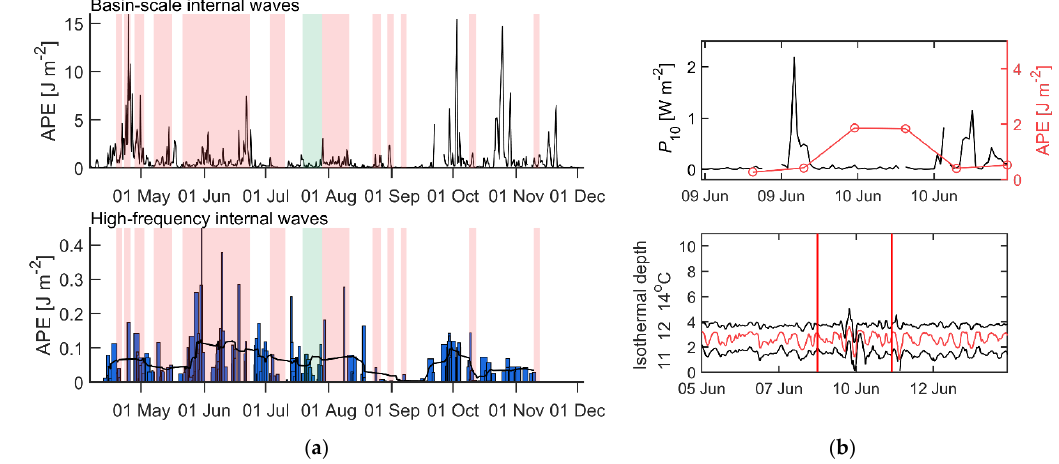
Figure 6. ( a ) Average available potential energy (APE) in basin-scale internal waves (upper panel) and in high-frequency internal waves (lower panel) throughout the measurement period in Bautzen Reservoir. The red-shaded areas correspond to the presence of the basin-scale waves with 8–9 h period, the green-shaded area shows the presence of a wave with 21 h period. The width of the bars is not to scale but is proportional to the event duration (i.e., narrow bars indicate shorter events where waves are present, and wider bars indicate longer events). The black line in the lower panel (a) shows a moving average of the APE. ( b ) Sample data demonstrating the transfer of wind energy to basin-scale internal waves. The upper panel shows the time series of P 10 and APE averaged over one wave cycle. After the wind event stopped, APE grows first and then decays after three wave cycles. The lower panel shows isothermal depths with the event duration marked by red vertical lines.